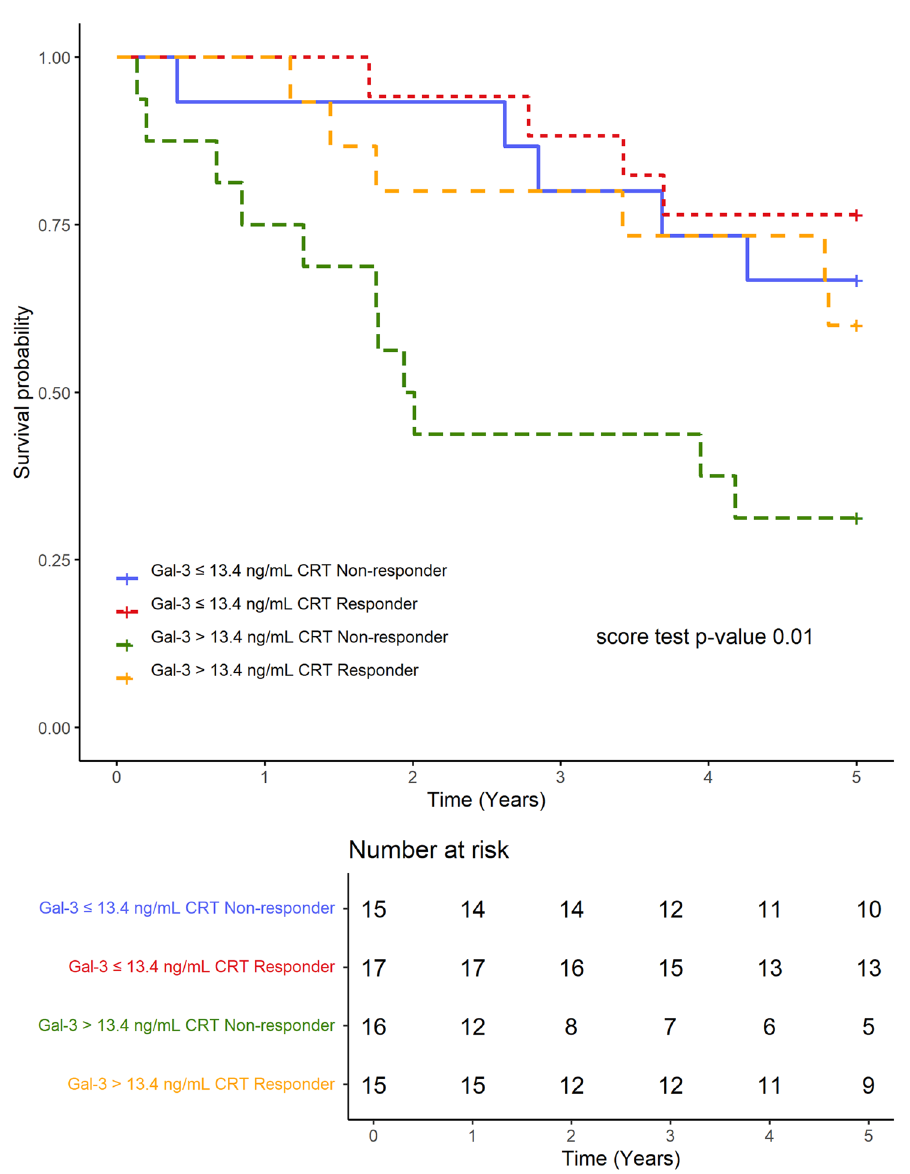
Figure 3. Title: Long-term survival following CRT-D according to the baseline Gal-3 concentration and CRT-D response. CRT-D: cardiac resynchronization therapy-defibrillator; Gal-3: galectin-3.